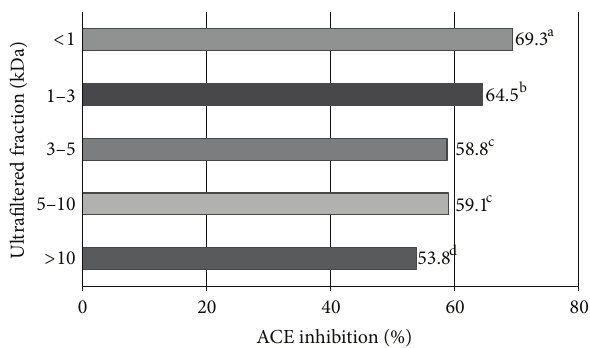
Figure 1: ACE-I inhibition percentage of peptide fractions obtained by ultrafiltration of a S. hispanica protein hydrolysate. a–d Different superscript letters indicate statistical difference ( 𝑃 < 0.05 ). Data are the mean of three